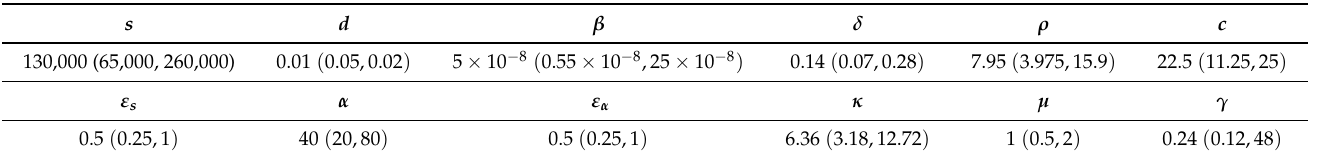
Table 2. Central values of the multiscale model for the PRCC. The (min, max) of the parameter space are